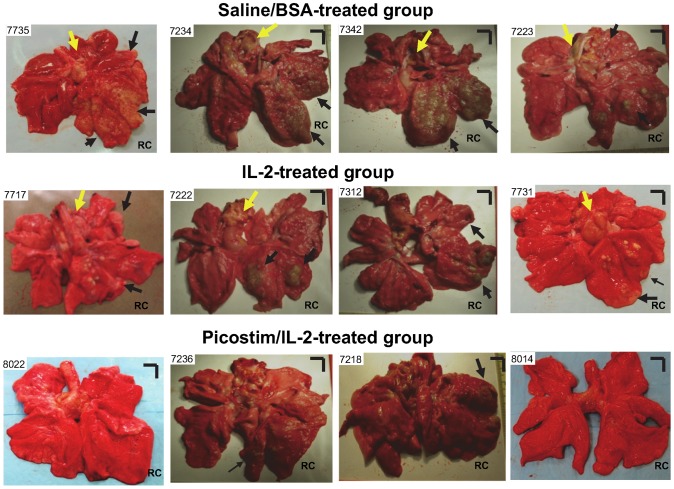
Picostim/IL2 treatment, while expanding Vγ2Vδ2 T cells, could confer immune resistance to TB lesions in lungs after pulmonary Mtb infection.Shown are digital photos of cut sections of lung lobes from 12 representatives of 27 macaques (9 for each group). Lungs and other organs were obtained in complete necropsy at day 65 after Mtb infection. Macaque ID numbers are shown in upper left corners, with the right caudal(RC) lobe (infection site) indicated in each photo. Extent and severity of the lesions could be adjudged based on the examples pointed by large arrows for caseation pneumonia or extensive coalescing granulomas and by small arrows for less coalescing or small granulomas. Yellow arrows indicate the enlarged hilar lymph nodes with caseation. Note that four Picostim/IL-2–treated macaques (ID 8022, 8014, 8013, 8006: first two animals shown in this figure and last two shown in Fig. S1 in Text S1) did not show any detectable gross TB lesions. Other five Picostim/IL-2–treated macaques displayed more focal, less coalescing or less caseating TB granulomas than control groups. (see Fig. S1 in Text S1). Vertical/horizontal bars at upper right corner of each photo represent the 1-cm scale derived from the fluorescence rulers of original photos. >50% of saline/BSA and 10% of IL-2–treated controls had extrathoracic TB dissemination, which was not seen in Picostim/IL-2-treated macaques. The efficacy evaluation was done sequentially in three separate trials each involving Picostim/IL-2 group and control groups of a total of 27 macaques.